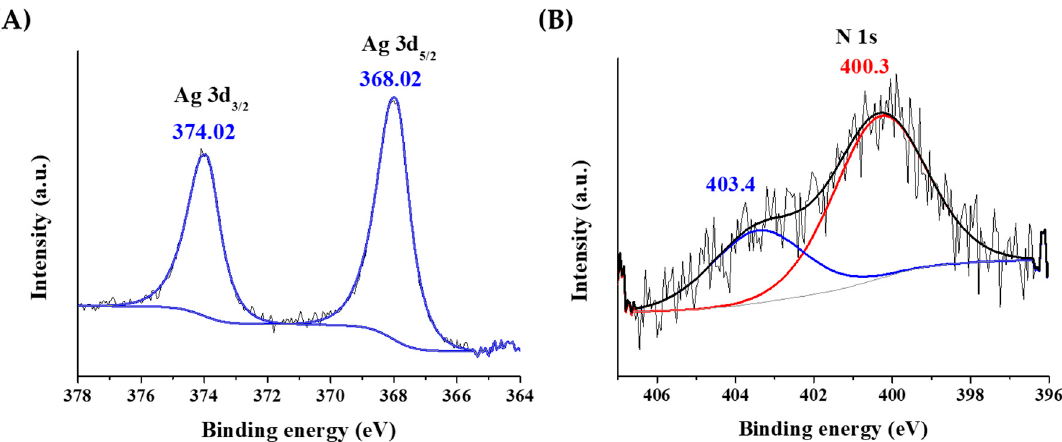
Figure 3. The X-ray photoelectron spectra of the ( A ) silver and ( B ) nitrogen atoms in Tyr-AgNCs. In Figure 3B, the different oxidation states of nitrogen can be also observed. One form at 400.3 eV might come from the amino groups at 399.4 ± 0.8 eV. The other form is at 403.4 eV, which belongs to an oxidized form of nitrogen due to the redox reaction taking place between the tyrosine ligand and Ag + ions.